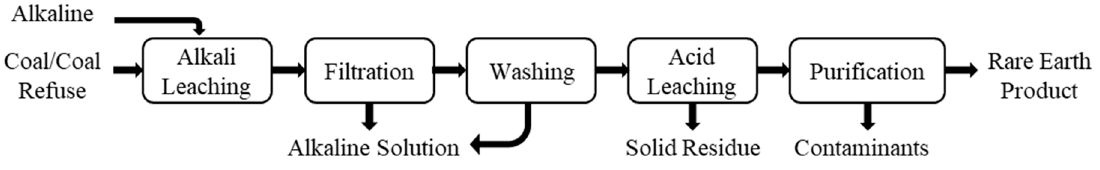
Figure 1. Schematic diagram of the alkaline-acid leaching process to extract REEs from coal and coal refuse [52].